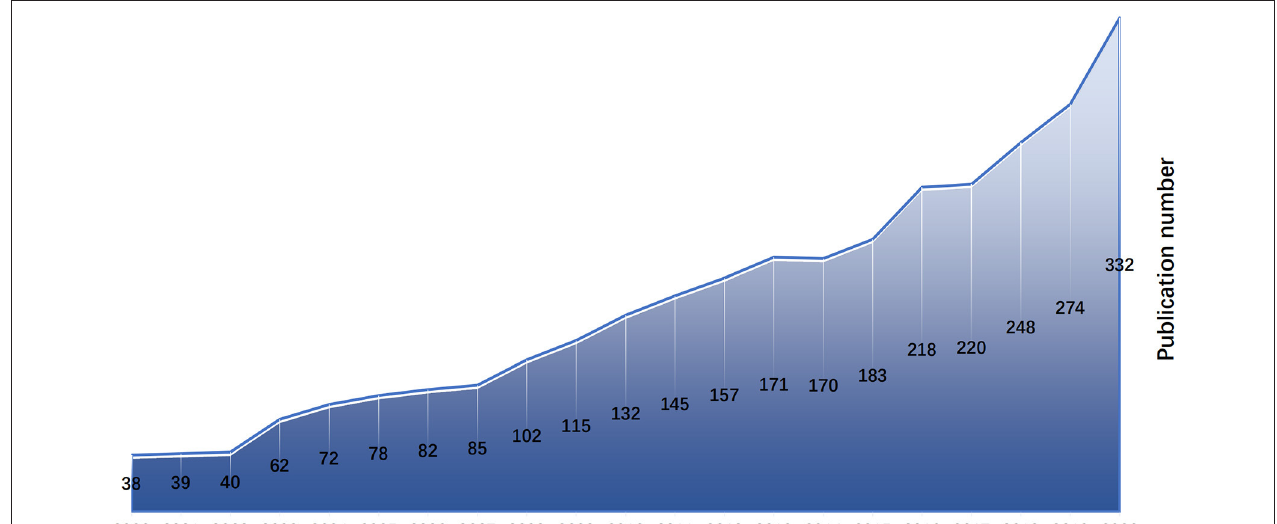
FIGURE 1 | Growth of scientific production on PPD from 2000 to